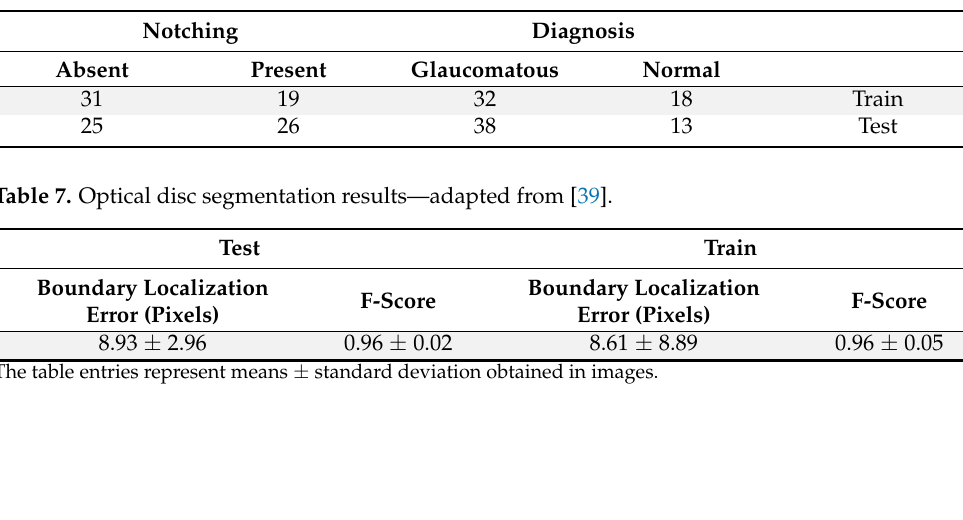
sets—adapted from [39].